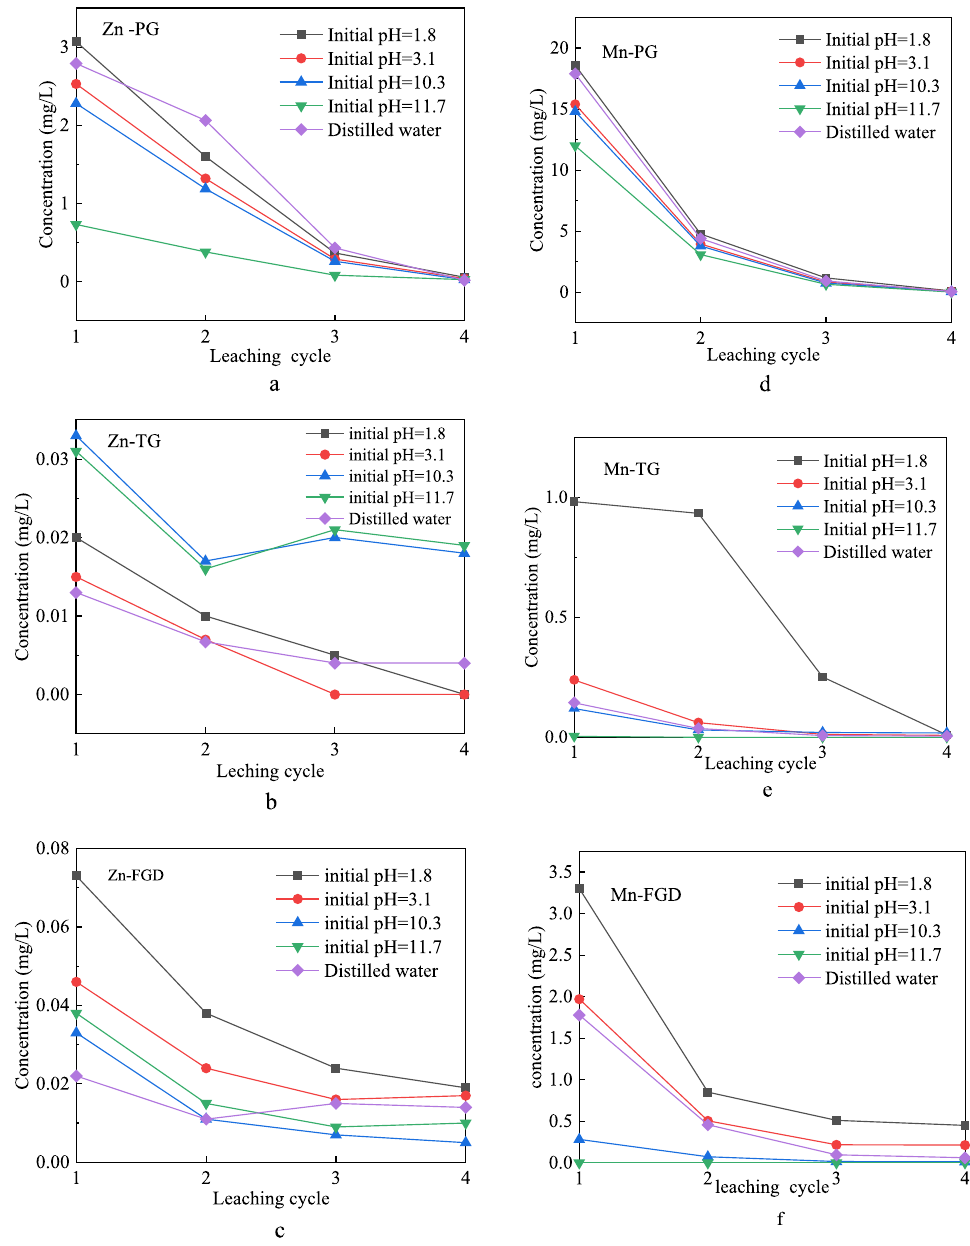
Fig. 4 Leaching concentrations of Zn in PG ( a ), TG ( b ) and FGDG ( c ); leaching concentrations of Mn in PG ( d ), TG ( e ) and FGDG ( f